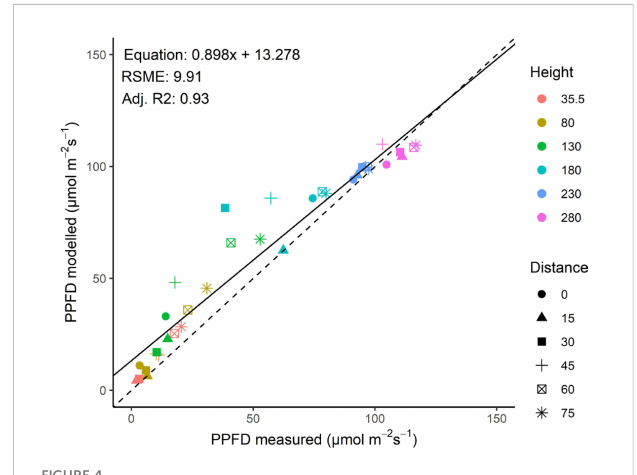
FIGURE 4 Relationship between measured and modelled incident PPFD (as observed by upward-facing sensors at different heights) in a greenhouse with a tomato crop illuminated by top lighting. The different symbols represent different distances to the middle of the rows in the canopy, whereas the symbol color represents height from the fl oor. Position of plants, lamps and sensors is shown in Figure